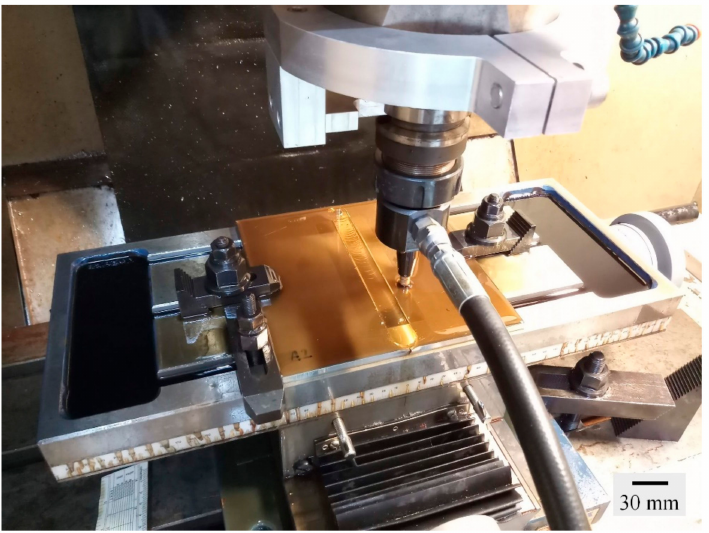
Figure 4. FSW workpiece during the deep-rolling (DR) process.